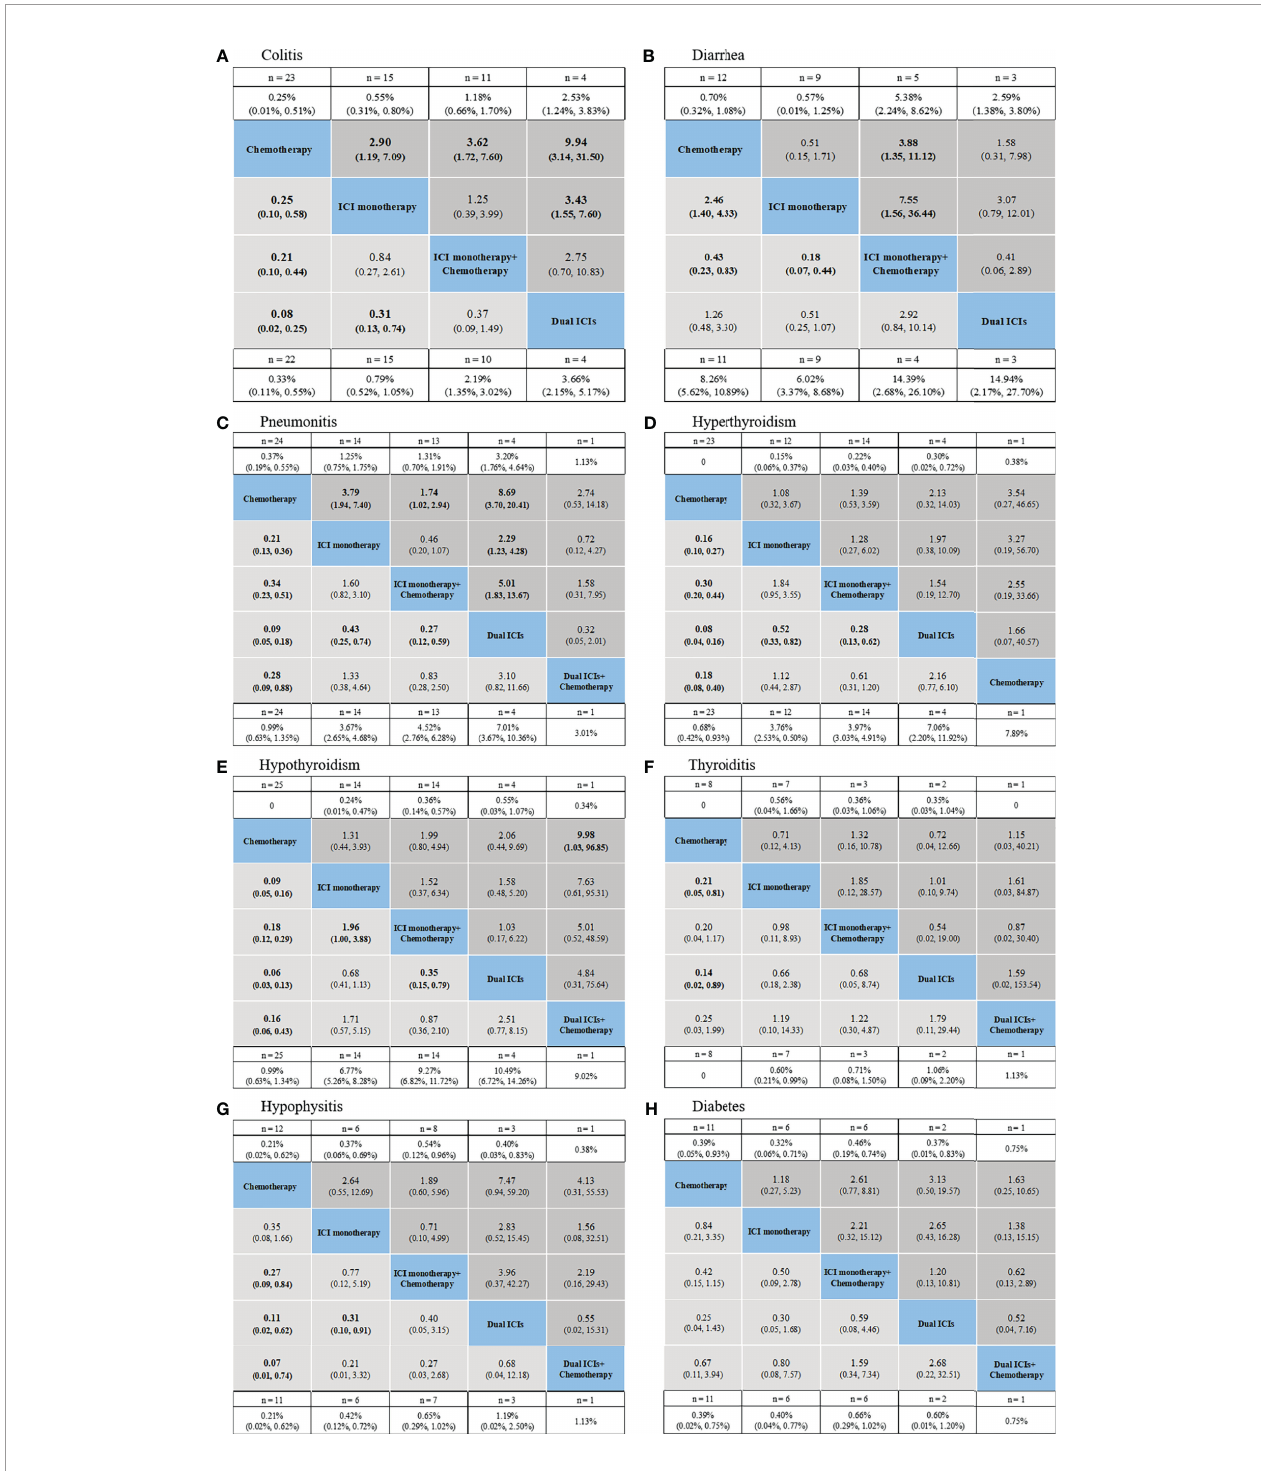
FIGURE 4 | Safety pro fi les based on speci fi c organs: colitis (A) , diarrhea (B) , pneumonitis (C) , hyperthyroidism (D) , hypothyroidism (E) , thyroiditis (F) , hypophysitis (G) , diabetes (H) . Pooled incidences and 95% con fi dence intervals of grade 1 – 5 events for each treatment are at bottom and that of grade 3 – 5 events are at top of the fi gure. Each cell of the safety pro fi les contains the pooled relative risks and 95% con fi dence intervals for grade 1 – 5 (light gray cell) and grade 3 – 5 (dark gray cell) events; signi fi cant results are in bold. The pooled relative risks and 95% con fi dence intervals indicate the results of the top treatment compared with the bottom treatment. ICI, immune checkpoint inhibitor; n,